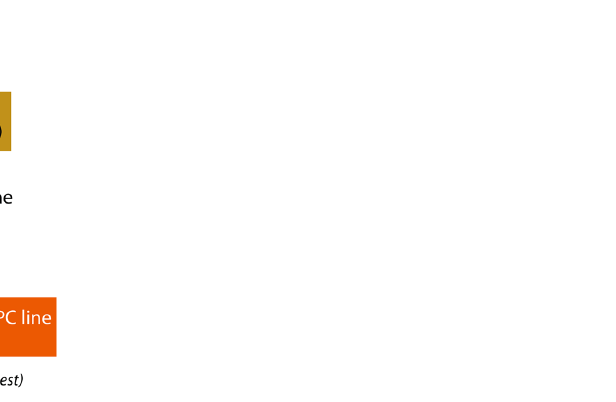
Figure 2. Overview results based on defining the PC line. All eyes are classified into two groups based on with or without the lens thickness inspection. The Right and the left half of the circle graph indicate the No inspection (warm colors) and the LT inspection group (cold colors), respectively. Using the CAT ARY S OCT subsystem, we are able to describe PC lines approximately 98%. Inspecting with the preoperative OCT image significantly reduces the number of cases that have a possibility to cause a severe complication (inappropriate PC